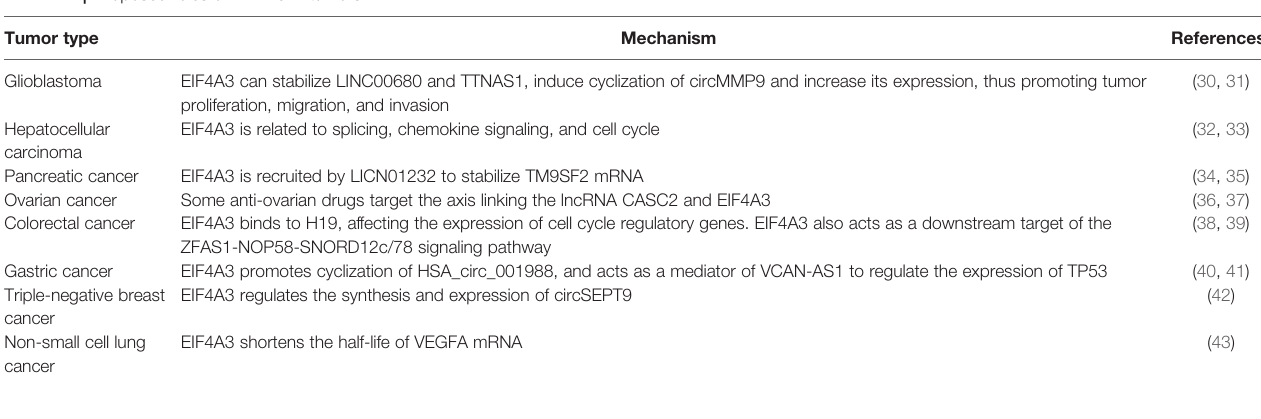
TABLE 1 | Proposed roles of EIF4A3 in